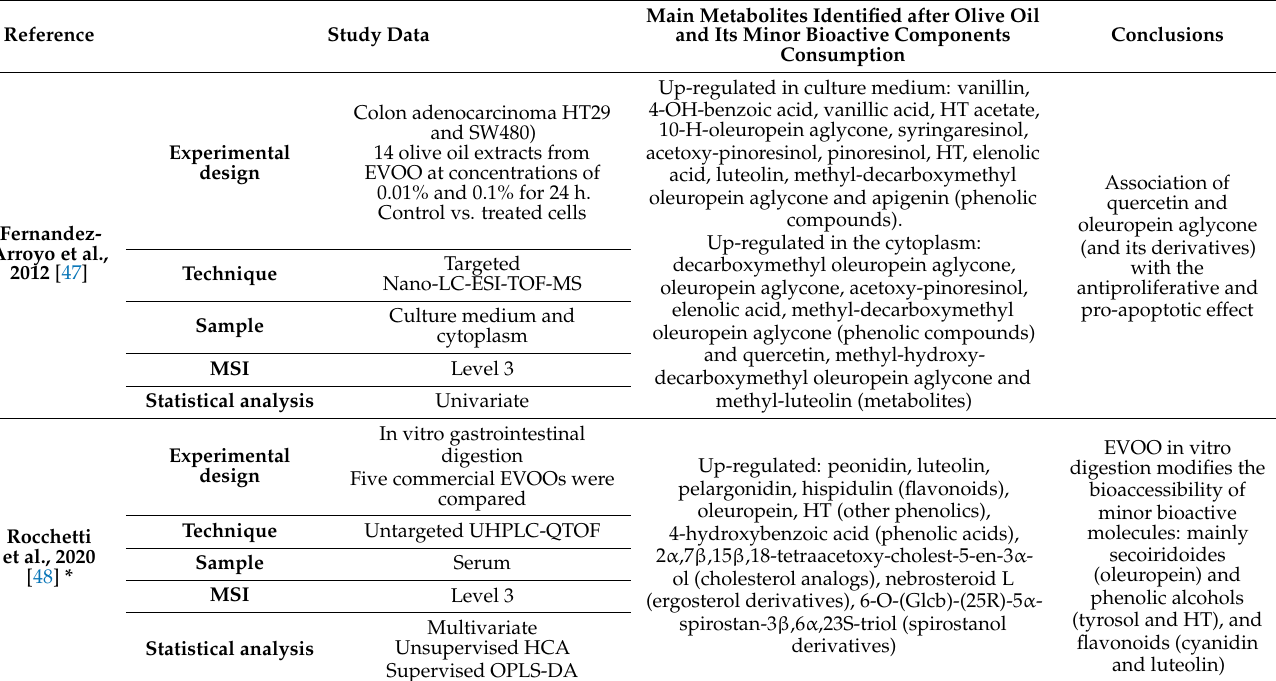
Table 4. Results of in vitro experimental metabolomics